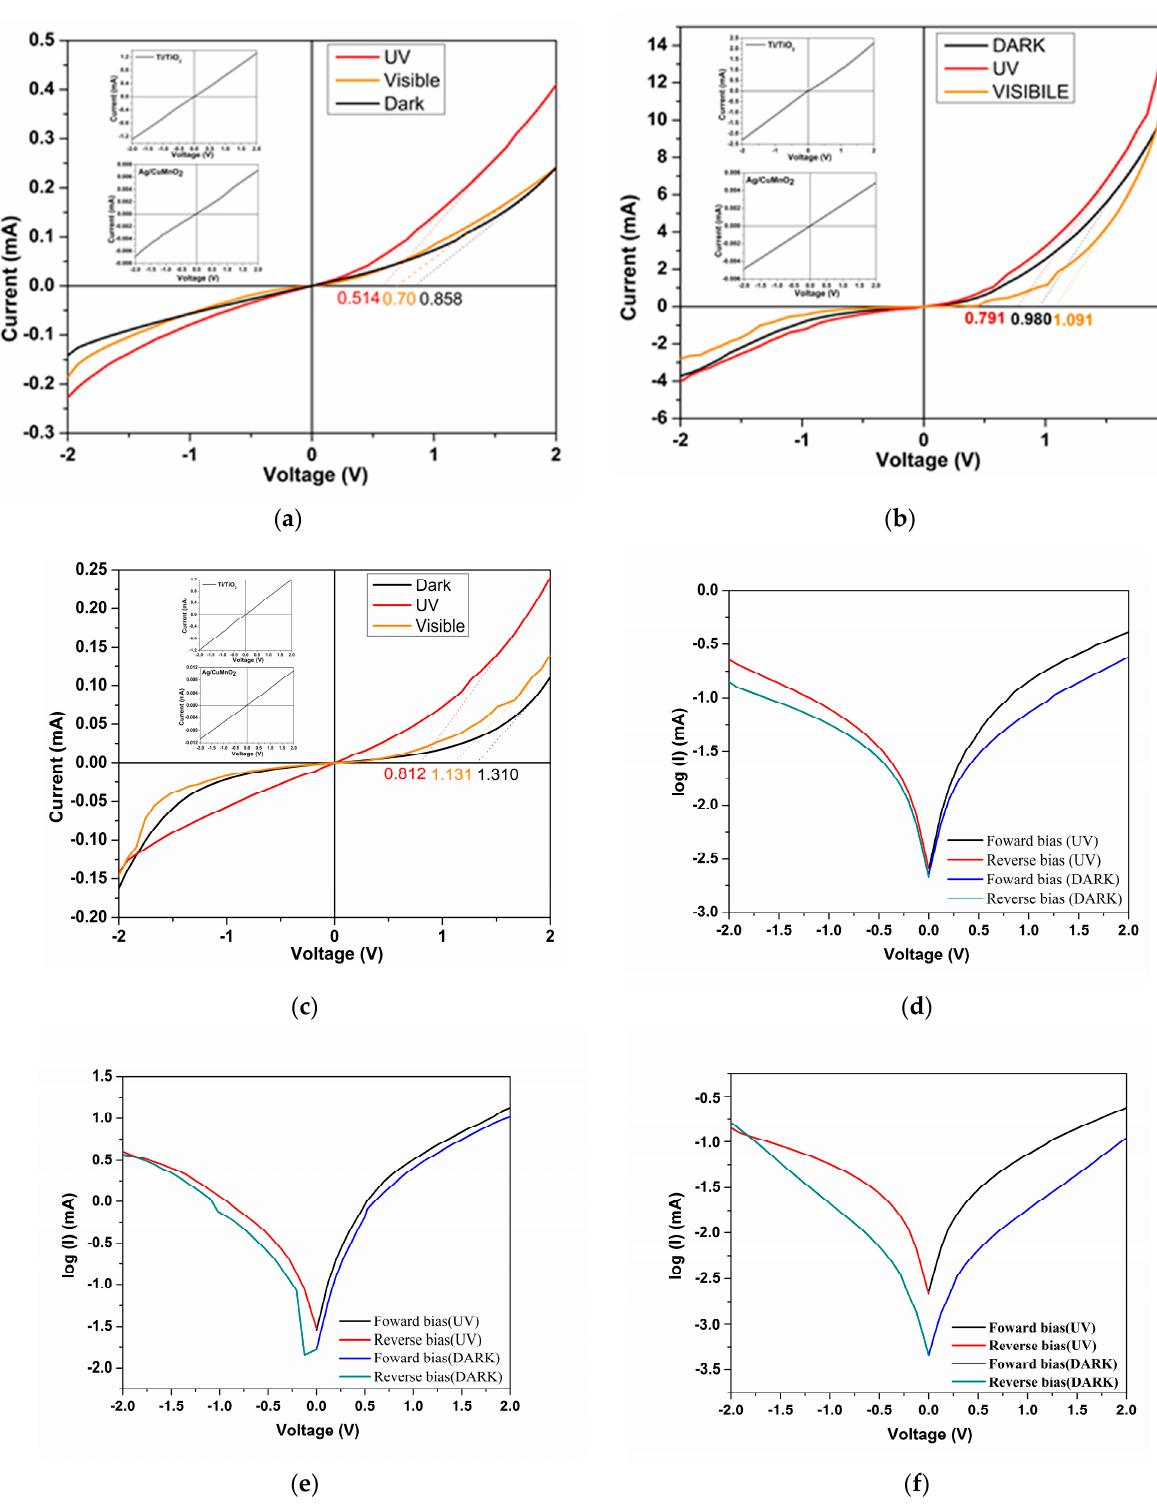
Figure 8. Current-voltage characteristics of n -TiO 2 / p -CuMnO 2 heterojunction for ( a ) S1a; ( b ) S2a and ( c ) S3a under dark, UV and Vis irradiation (Inset: ohmic contact measurements); Log from forward and reverse bias for ( d ) S1a; ( e ) S2a and ( f ) S3a, under dark and UV illuminated conditions.